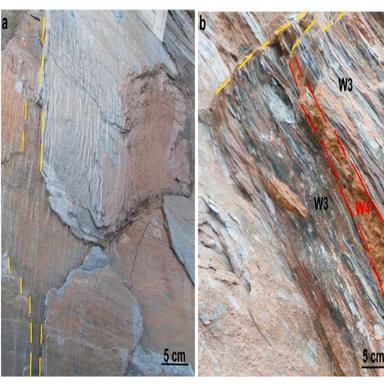
Ruptures perpendicular to the foliation in the crenulation cleavage direction, highlighted in yellow (a and b), and the openings parallel to the foliation, in red, create preferred paths for the chemical weathering action. In particular, parallel openings provide abrupt contact between materials with different degrees of weathering (b). A scale is presented to allow comparison to grain sizes. (For interpretation of the references to color in this figure legend, the reader is referred to the Web version of t